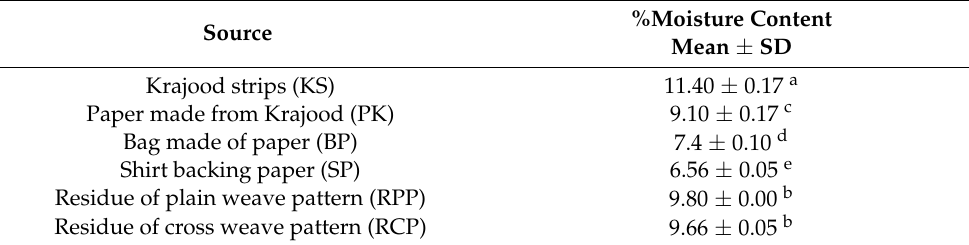
Table 1. Percentage of moisture content of each sample.